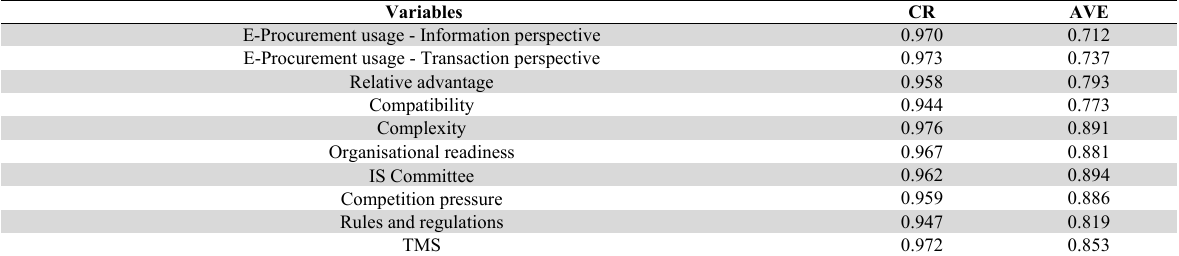
Reliability and Validity